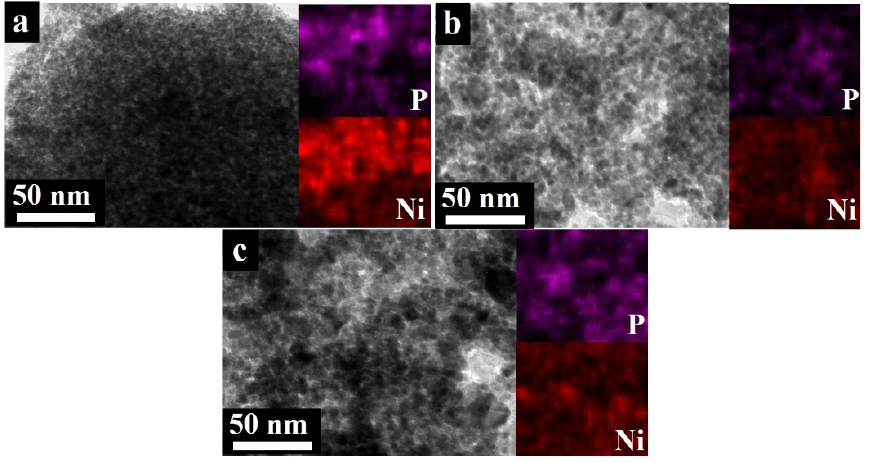
Figure 3. TEM images of the Ni-P crystallized at different temperatures: ( a ) Ni-P 300, ( b ) Ni-P 400, and ( c ) Ni-P 500; and the insets are the EDS mapping images of the corresponding samples.